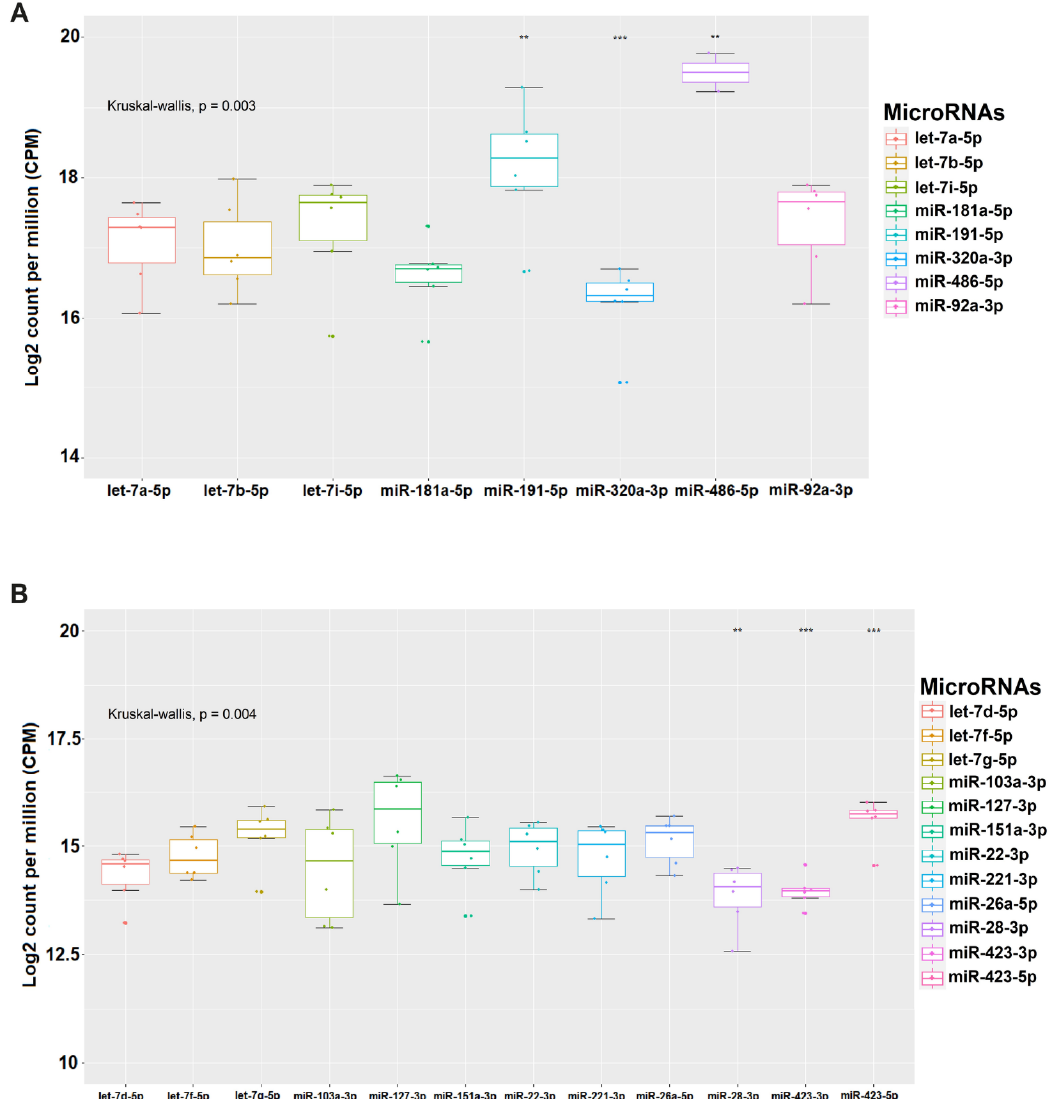
Figure 2. Di ff erent measures of expression level in PCs ( A ) and ( B ) with the normalized expression level in Log 2 (CPM) of the 20 miRNAs most expressed. The boxplot is designed from the 75th to the 25th percentile. The vertical lines above and below the box define the maximum and minimum Figure 2. Different measures of expression level in PCs (A) and (B) with the normalized expression level in Log 2 220 values and the dots indicate outliers, the horizontal line inside the box represents the median value. (CPM) of the 20 miRNA s most expressed. BoxPlot is designed from the 75 th to the 25 th percentile. The vertical 221 The Kruskal–Wallis test p -value < 0.001, in all cases was applied to compare the means among the lines above and below the box define the maximum and minimum values and the dots indicate outliers, the 222 horizontal line inside the box represents the median value. Kruskal-Wallis test p-value <0.001, in all cases was 223 miRNAs expressed in all PCs (** p < 0.01 and *** p = 0.001). Two groups of miRNAs were applied to compare the means between the miRNAs expressed in all PCs (** p < 0.01, *** p = 0.001) . Two groups 224 of miRNAs were established to compare the relative expression by the analytical method previously mentioned 225 to evaluate the PC bags. 226